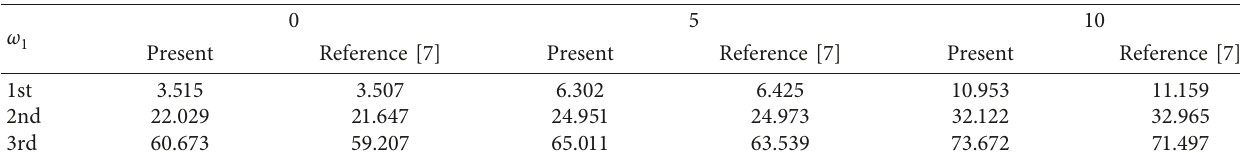
Table 1: Comparison of the first three dimensionless natural frequencies of elastic cantilever rotating beams at g � 0, α � 0, r � 0, and r � 0 . 125. 0